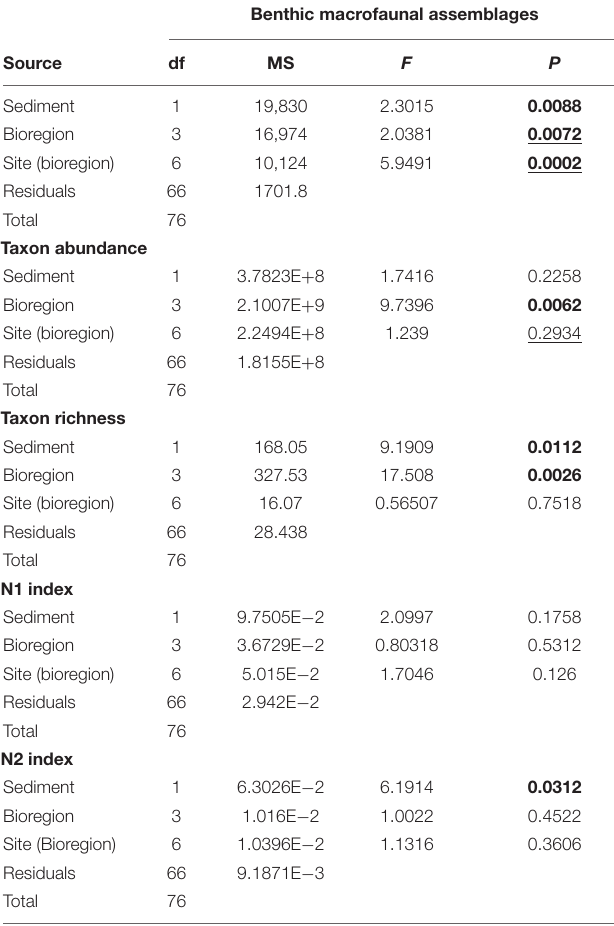
TABLE 2 | Results of PERMANOVA to test for differences in benthic macrofaunal assemblages between bioregions (fixed) and sites (random, nested within